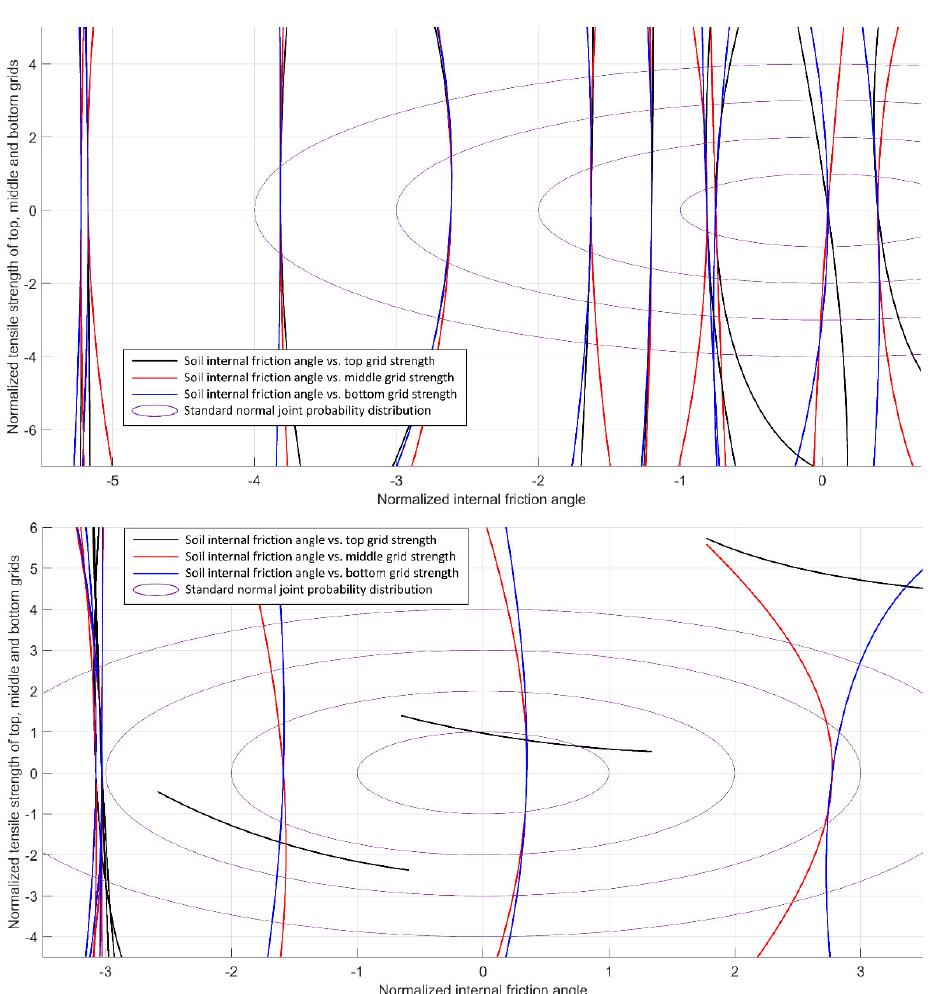
Figure 10. Limit state functions for LSF10 ( top ) and LSF15 ( bottom ).